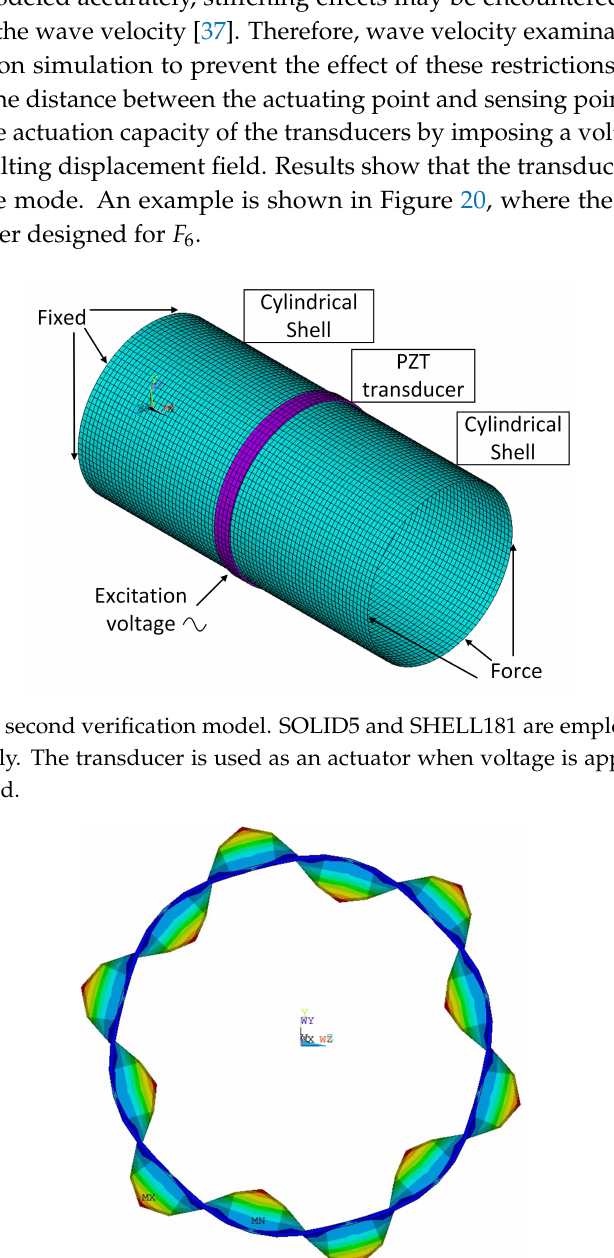
Figure 20. Displacement field of cylinder excited by F 6